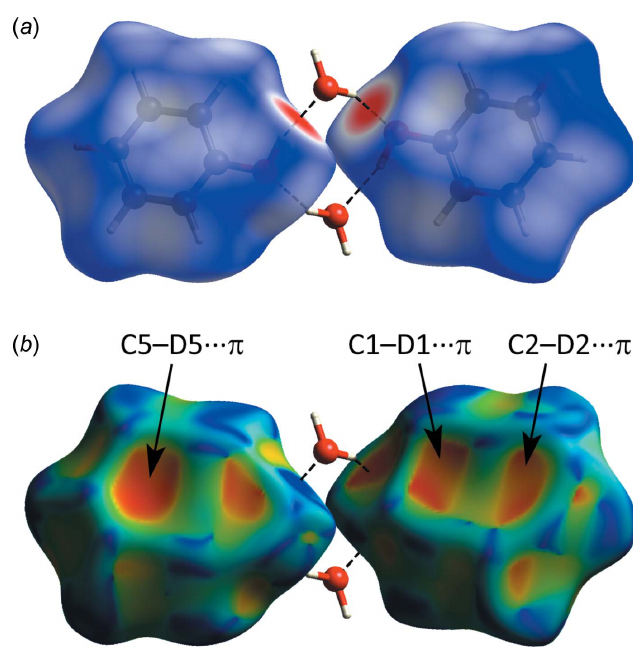
Figure 6 Hirshfeld surfaces of phenol hemihydrates, superimposed on the inversion dimer shown in Fig. 2. Surfaces are shaded by ( a ) d norm value and ( b ) the shape-index. Regions of important intermolecular contacts referred to in the text are labelled (see also Table 1). Two-dimensional fingerprint plots are shown in Fig. 7. The O (cid:2) (cid:2) (cid:2) H/H (cid:2) (cid:2) (cid:2) O hydrogen-bonded contacts appear as the two sharply pointed regions spreading to the top right from d ’ 1.82 A˚ ; these represent 15.2% of the Hirshfeld surface